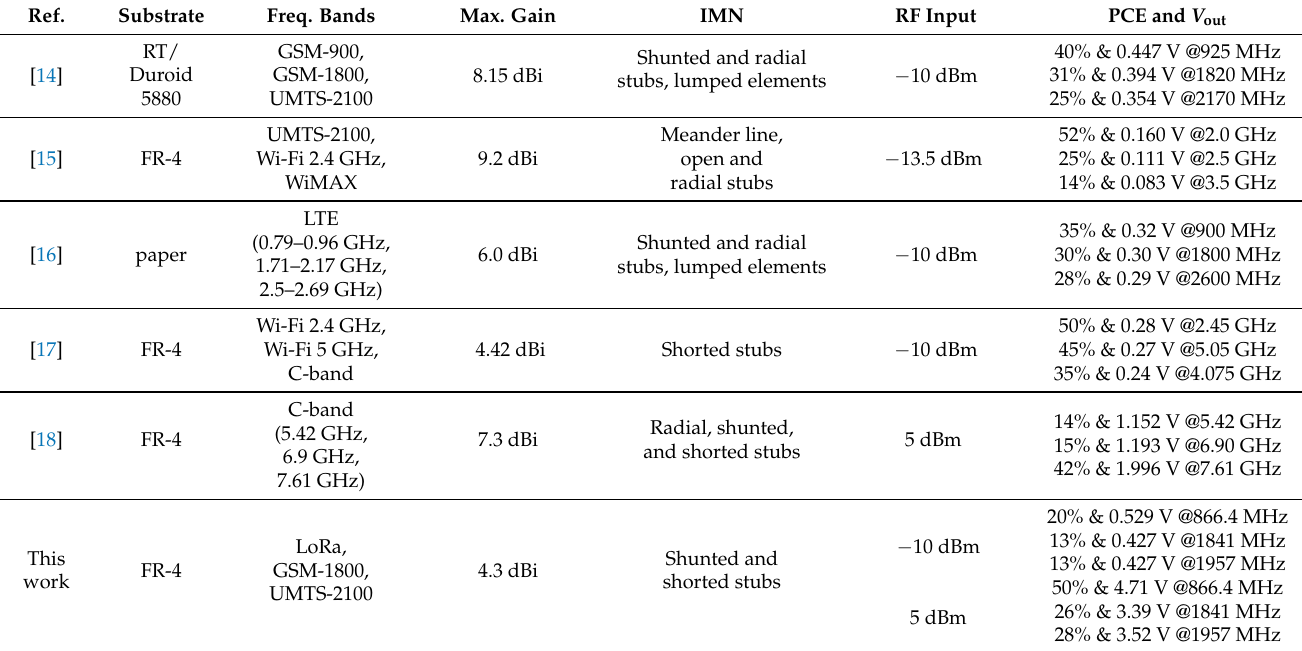
Table 5. Comparative measured results of the proposed triple-band rectenna against related work.